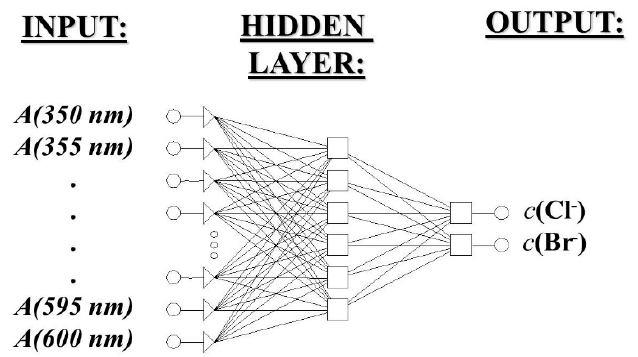
Figure 5. Example of optimal architecture (51:6:2) of artificial neural network (ANN) employed for Cl − and Br − analysis in mixture.